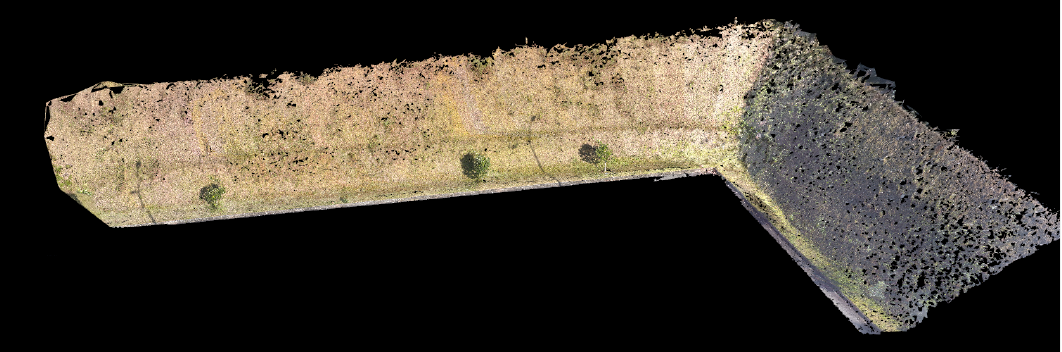
Figure 17. Optimized 3D